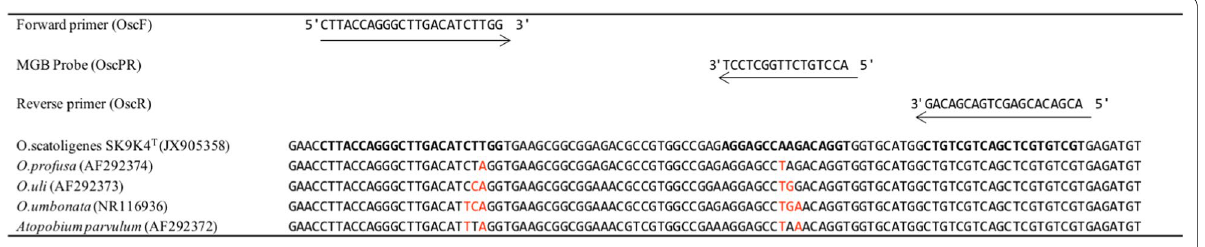
Fig. 1 Sequence targeted by the O. scatoligenes -specific MGB probe and primers, taking into account analogous sequences in the closely related Olsenella species and Atopobium species. Mismatches are marked in